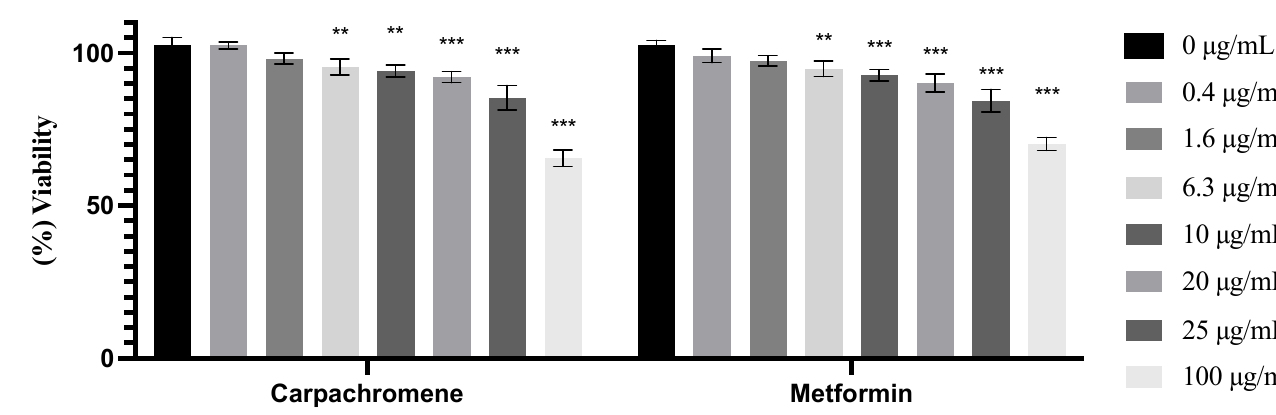
Figure 2. Cell viability after treatment with different concentrations (0.4, 1.6, 6.3, 10, 20, 25, 100 μ g/mL) of carpachromene or metformin on HepG2/IRM cells for 48 h. Bars represent mean ± SD. Significant difference was analyzed by two-way ANOVA test followed by post hoc Dunnett test, where ** p < 0.01, *** p < 0.001, compared to untreated HepG2/IRM cells.